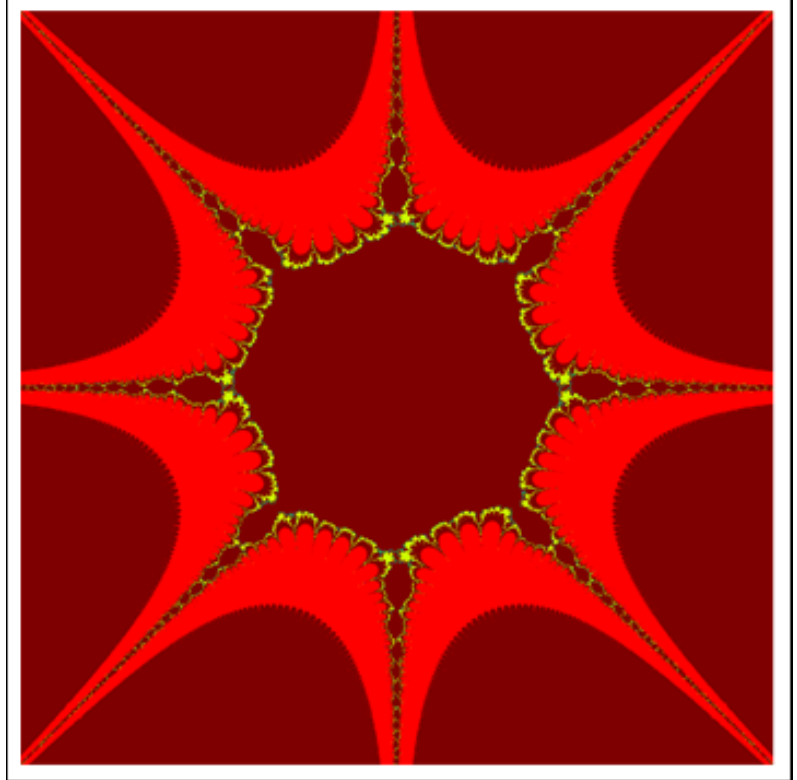
Figure 3. J-set for τ ( z ) = sin ( z 4 ) + c via DKIS. The image execution time is 571.688